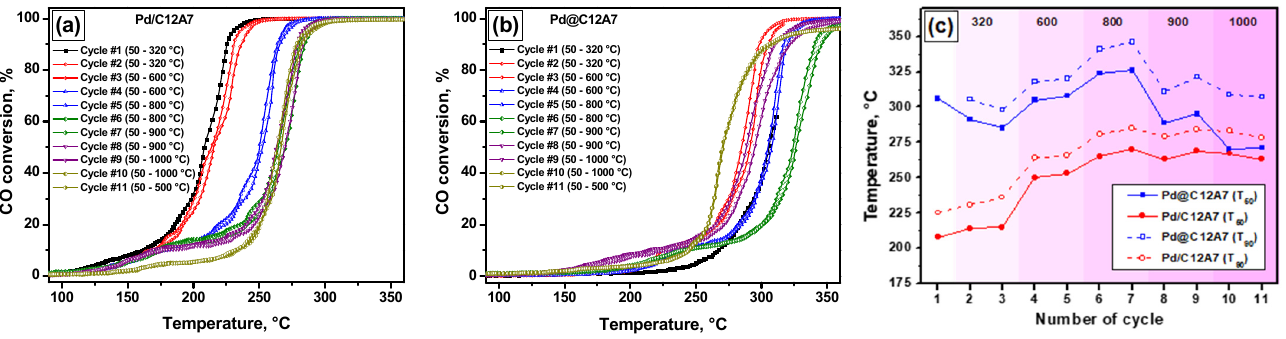
Figure 6. Light-off curves in the PTA mode for the samples: ( a ) Pd/C12A7; ( b ) Pd@C12A7. Comparison of the corresponding T 50 and T 90 values for these samples ( c ).